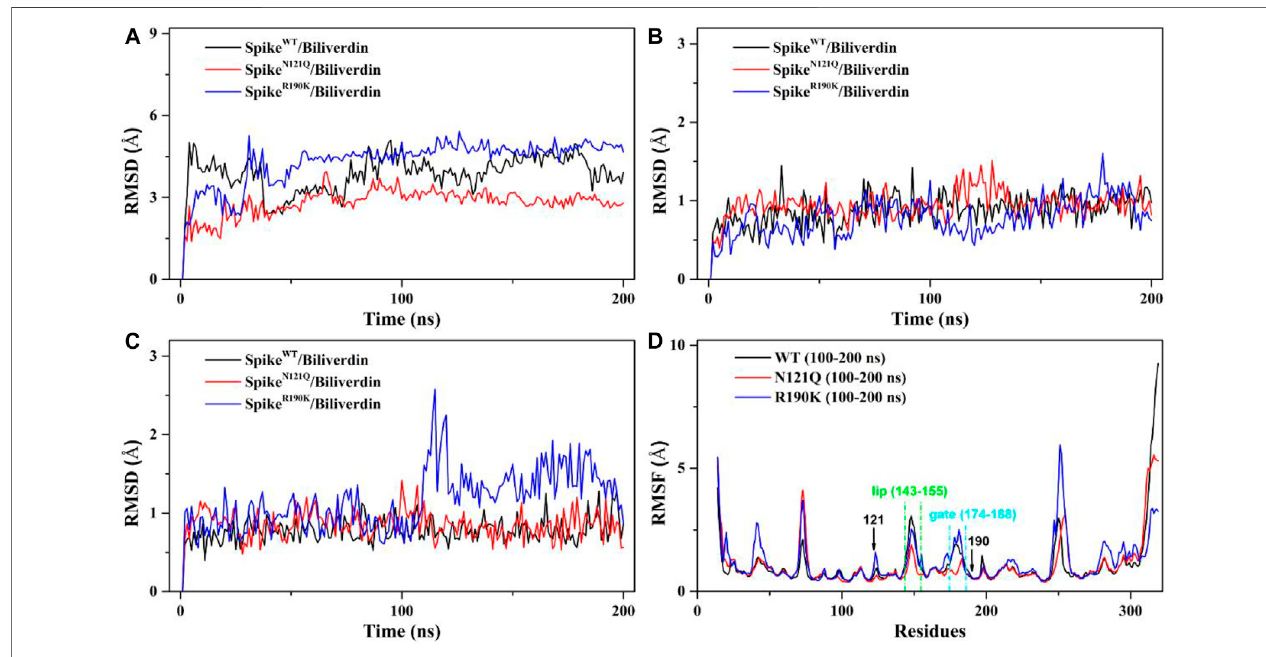
FIGURE 2 | (A) RMSD of the backbone atoms in the three systems relative to their single initial structures. (B) RMSD of the backbone atoms in the “ lip ” region. (C) RMSD of the backbone atoms in the “ gate ” region. (D) RMSF of the backbone atoms in the three systems relative to their respective initial structures in 100 – 200 ns.